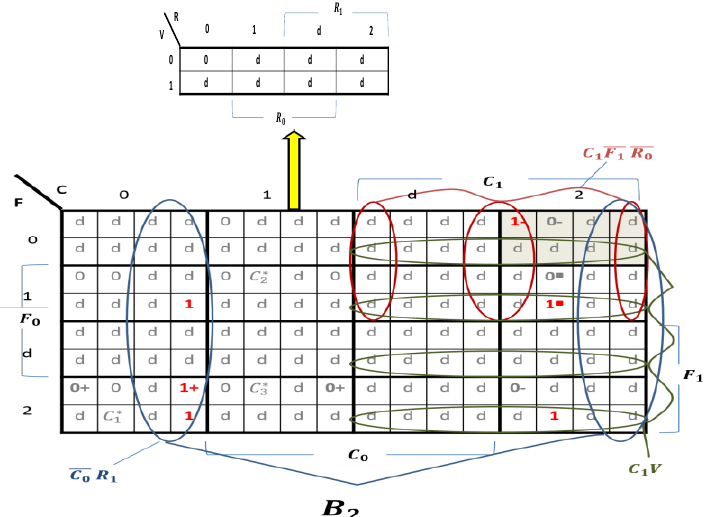
Fig. 3. A representation of 𝑩 in Hartmann and Kemmerzell (2010), with prime implicant loops covering the asserted part 𝑩